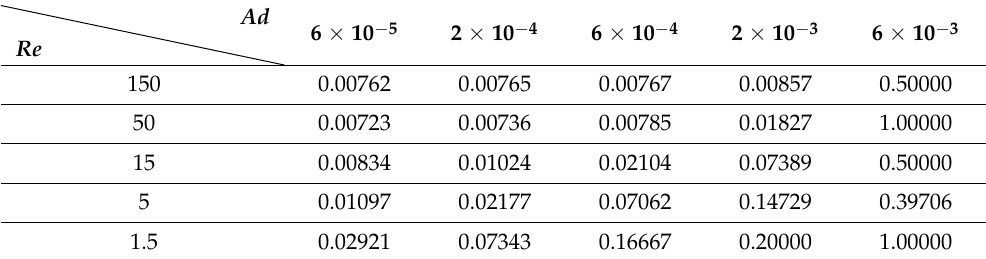
Figure 3. Steady − state structures of solid particle aggregates in the x − y plane side view (length along x and y directions: W (75 mm) × H (200 mm)) at a solid particle volume fraction of 4.2% for different Reynolds numbers and adhesion numbers. Table 3. Relative average aggregate size n * for different Reynolds Re and adhesion Ad numbers at a solid particle volume fraction 4.2%.